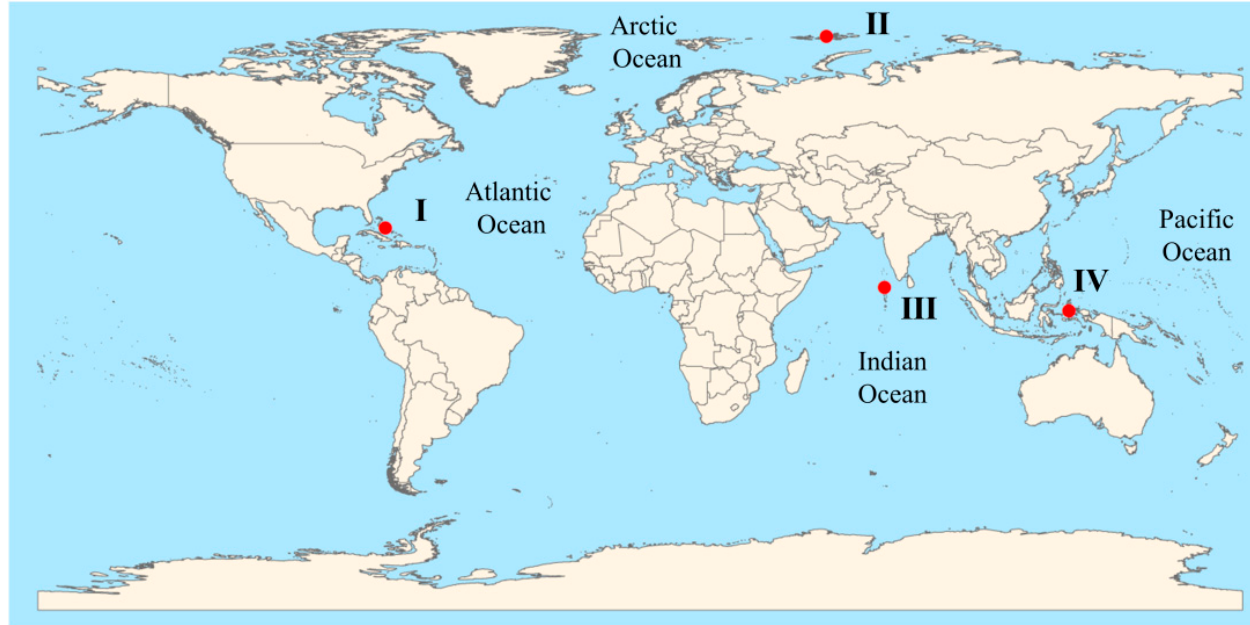
Figure A1. Locations of the four study areas.